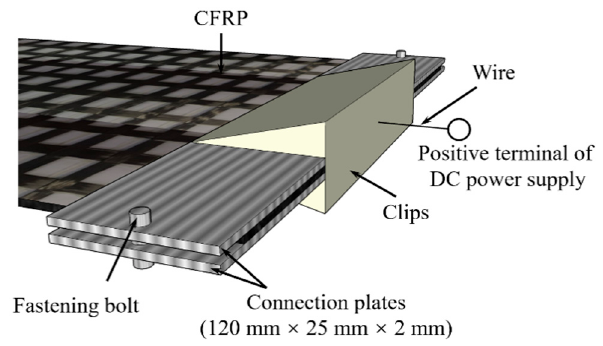
Figure 2. Details of the connection at the CFRP.